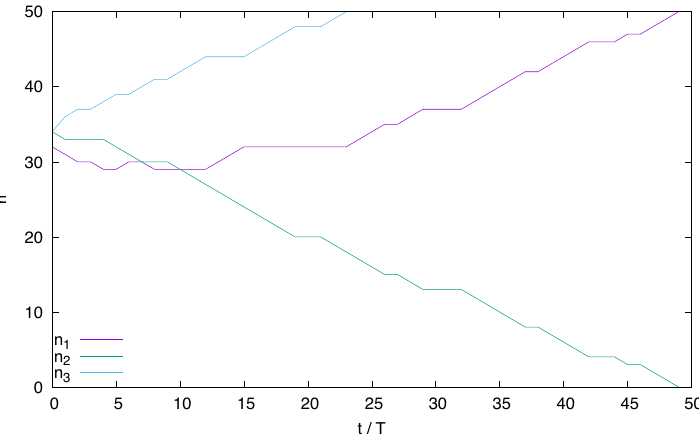
Figure 1. Numbers of containers on all nodes n versus time t